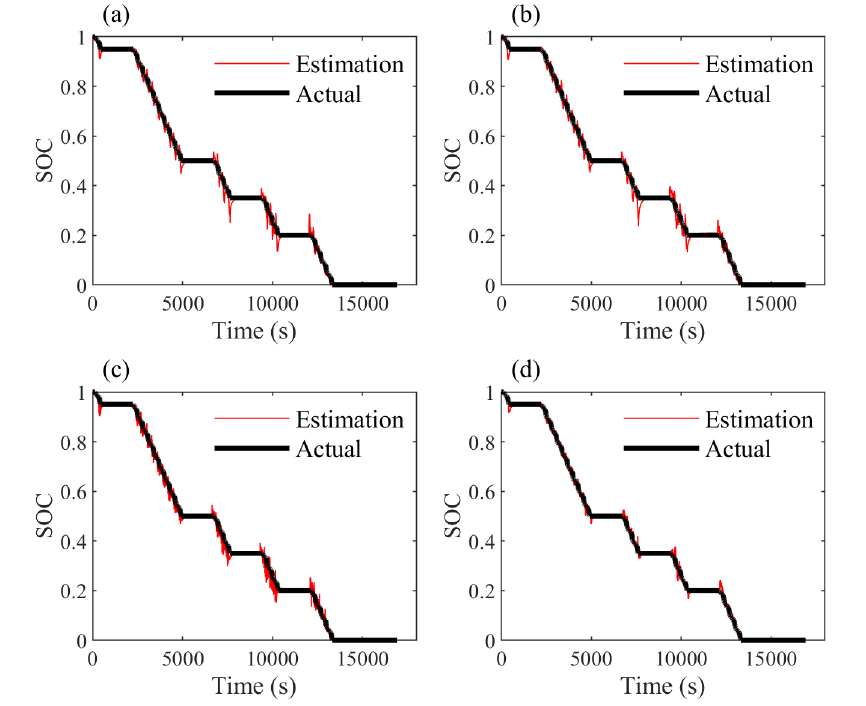
Figure 18. SOC estimation results for the DST profile with different pre-process methods: ( a ) average values, ( b ) moving average filter, ( c ) finite impulse response, and ( d ) wavelet